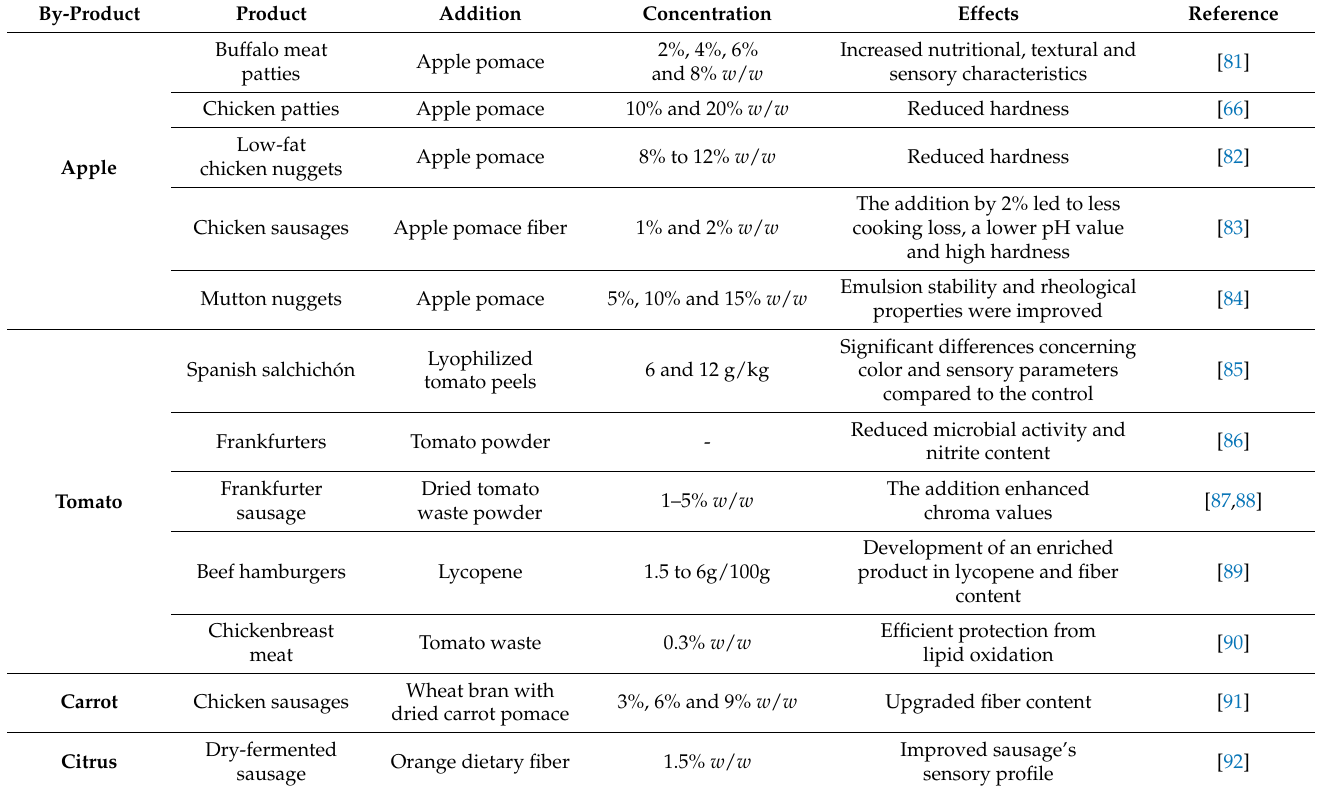
Table 3. Addition of agri-food by-products to meat